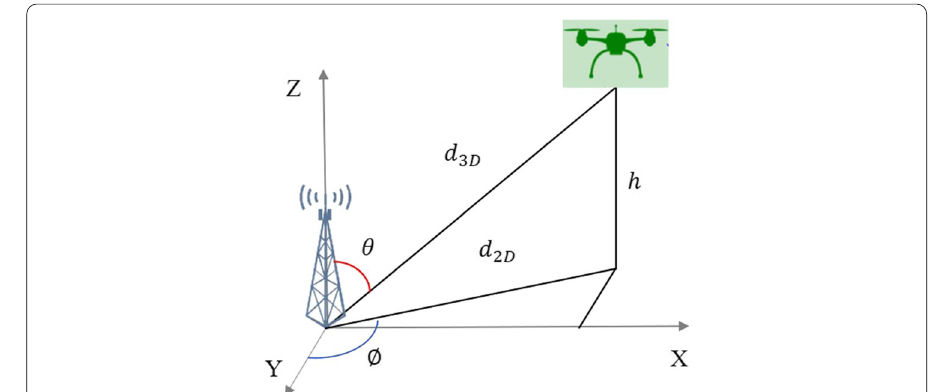
Fig. 3 The UAV-ground propagation path in open airspace